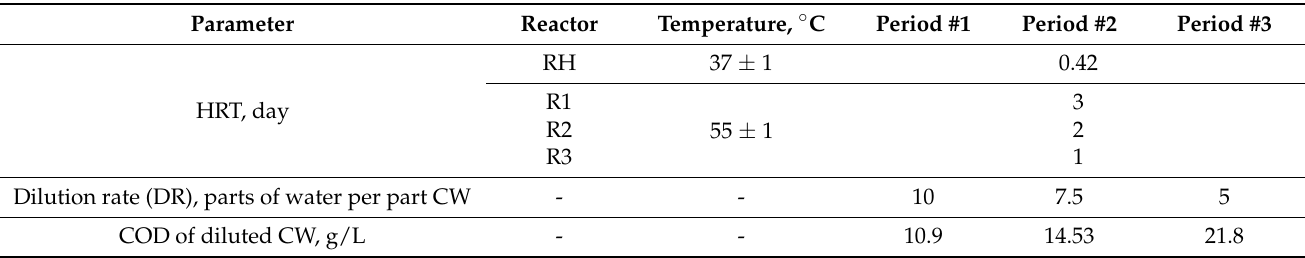
Table 1. Operating parameters of two-stage AD of CW.